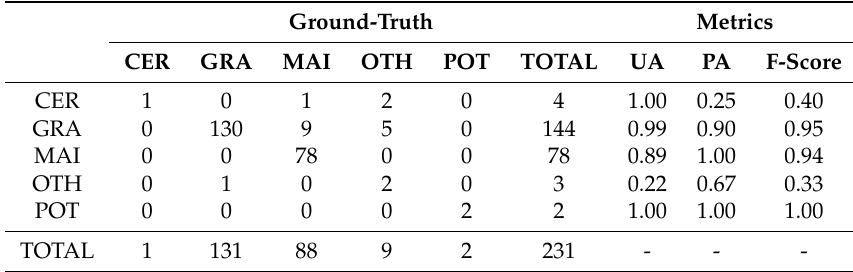
Table 7. Confusion matrix of the BRP2017 parcels with the ground-truth collected during the field survey along with the per-class user accuracy, producer accuracy and